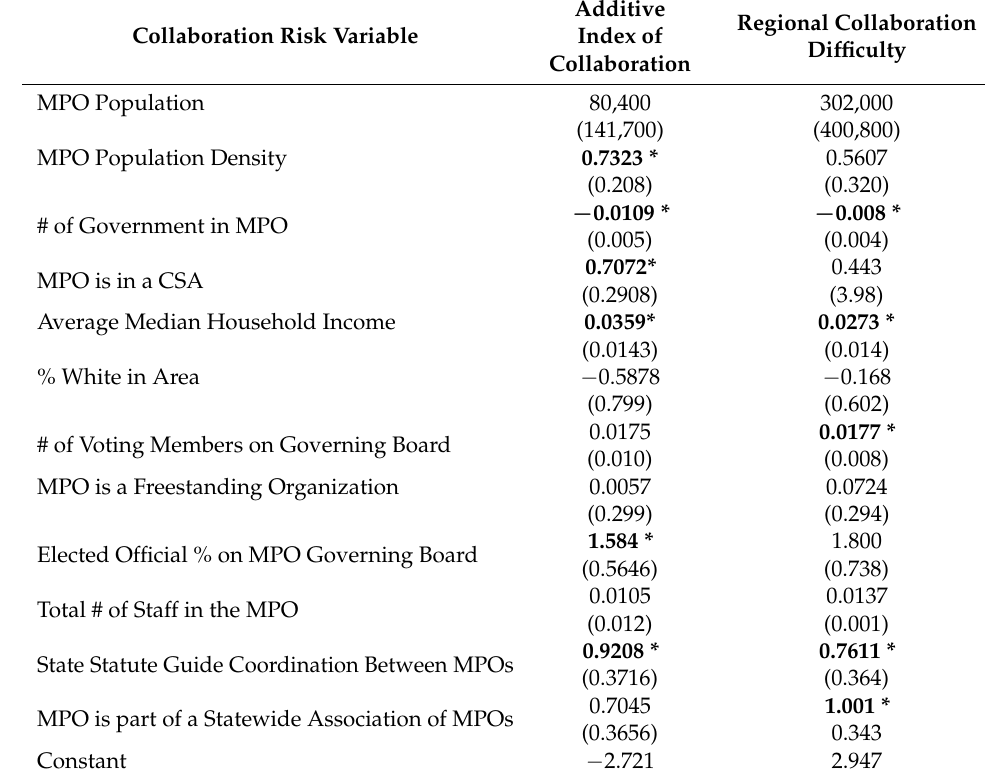
Table 5. Comparison of additive index and IRT difficulty score regression estimates.